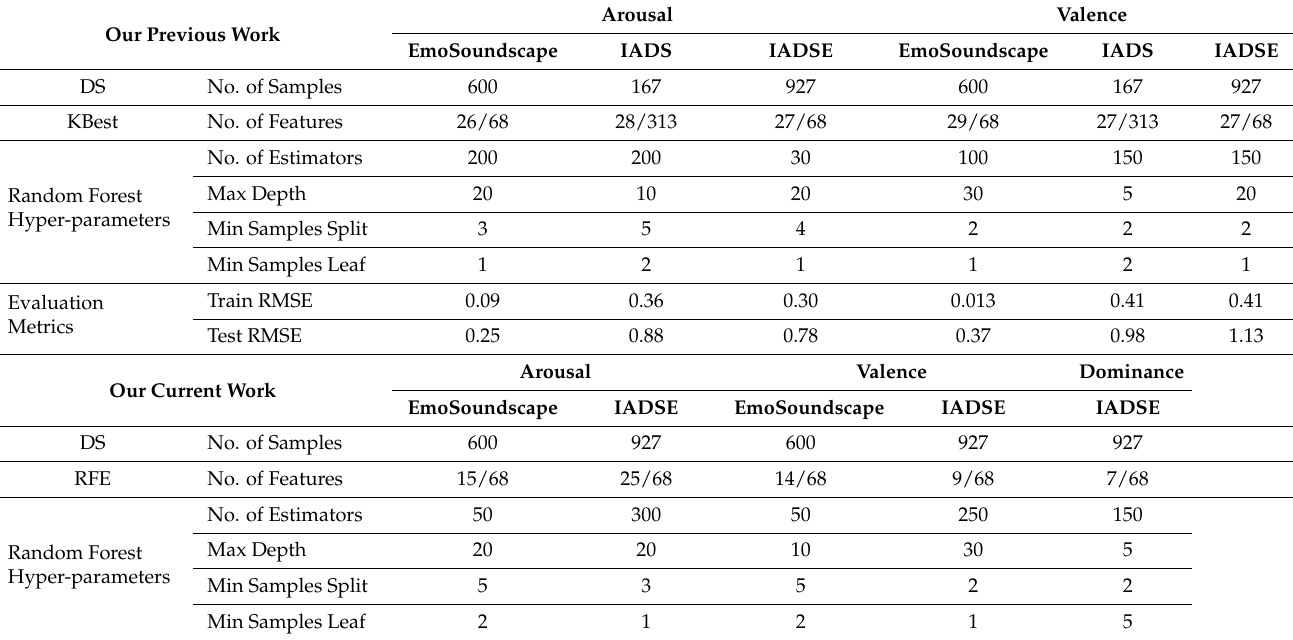
Table 6. The results of our previous and current